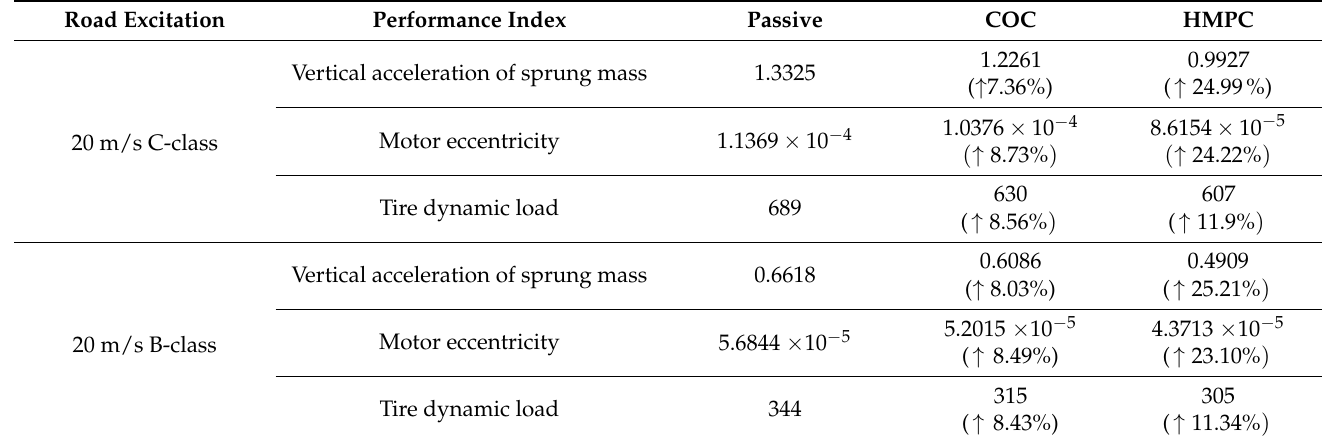
Table 3. The RMS values of HM-EV evaluation index.